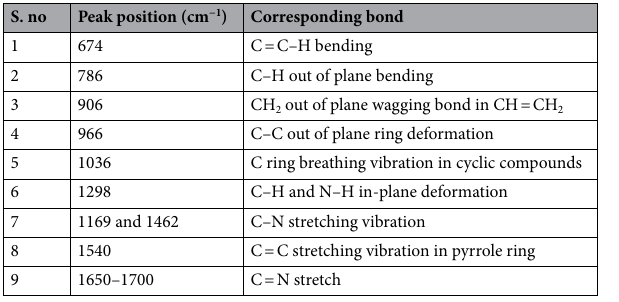
Table 3. FTIR transmission peaks and their assignment in PPy which confirms the formation of MIP, NIP and PPy-TMAO through different